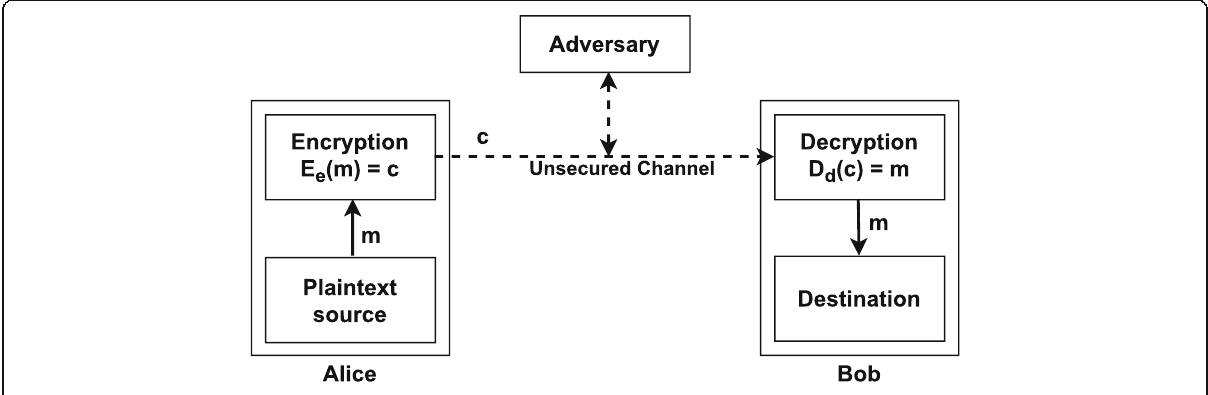
Fig. 1 The model of a two-party communication using encryption